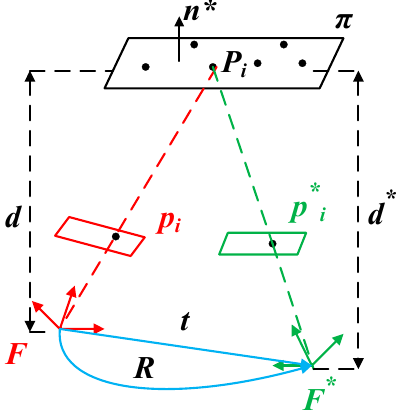
Figure 1. Projective homography model.